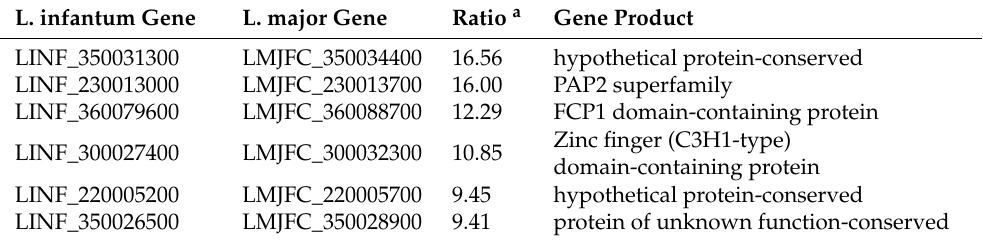
Table 2. Transcripts with marked different steady-state levels in L. infantum and L. major promastigotes. L. infantum